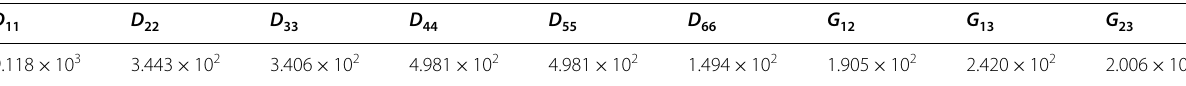
Table 6 Parameters in stiffness matrix of the glulam (Unit: N/mm 2